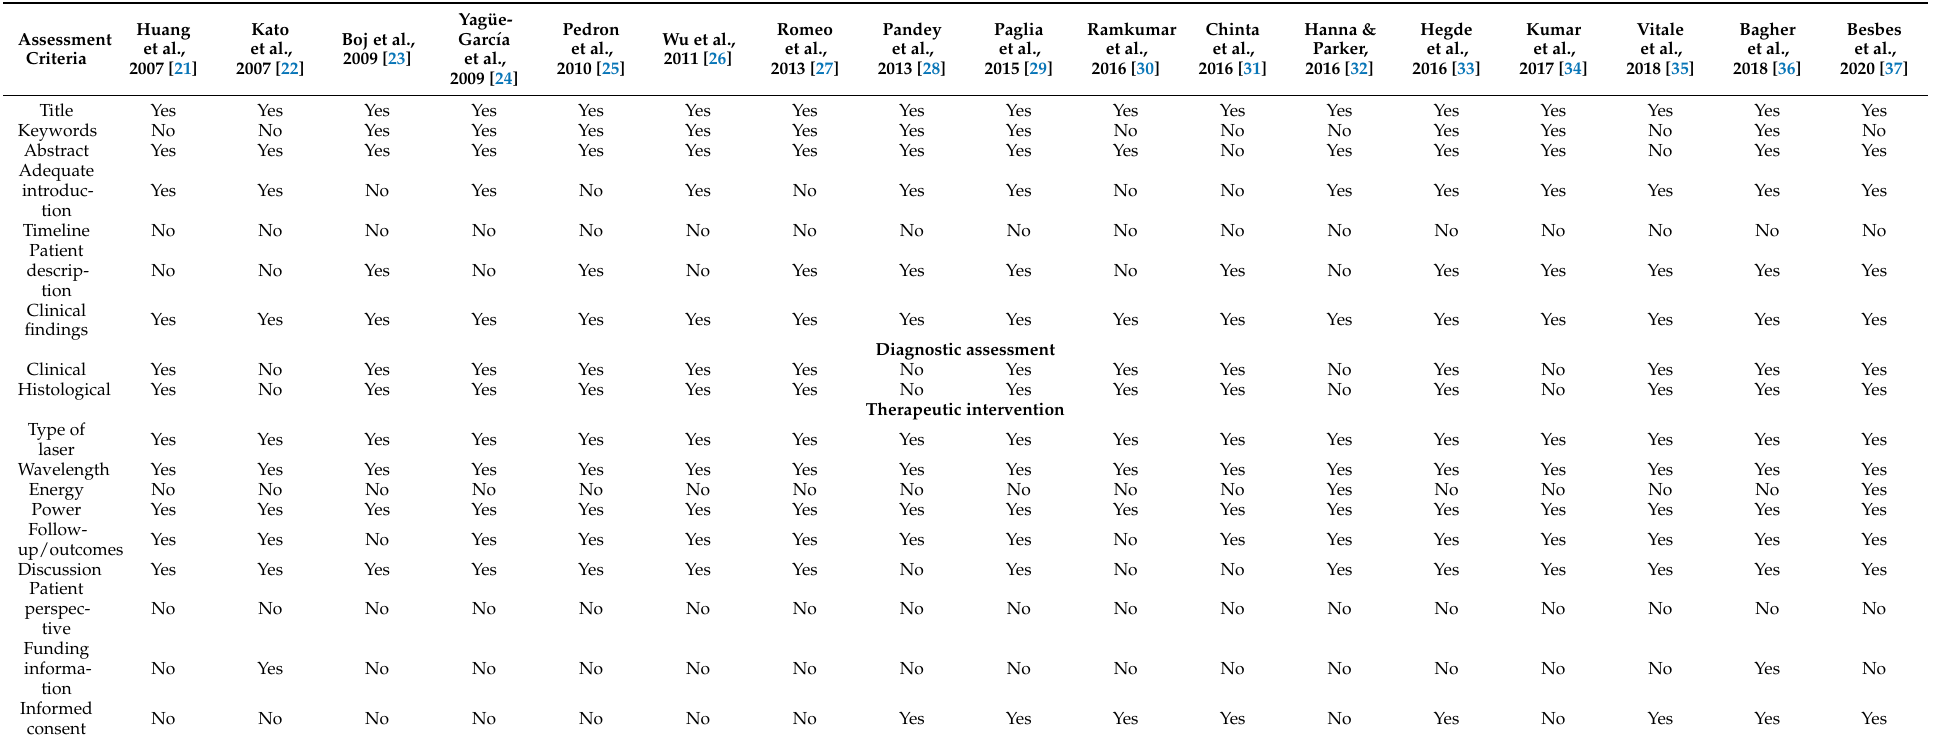
Table 3. Results of the quality assessment of the included studies according to CARE